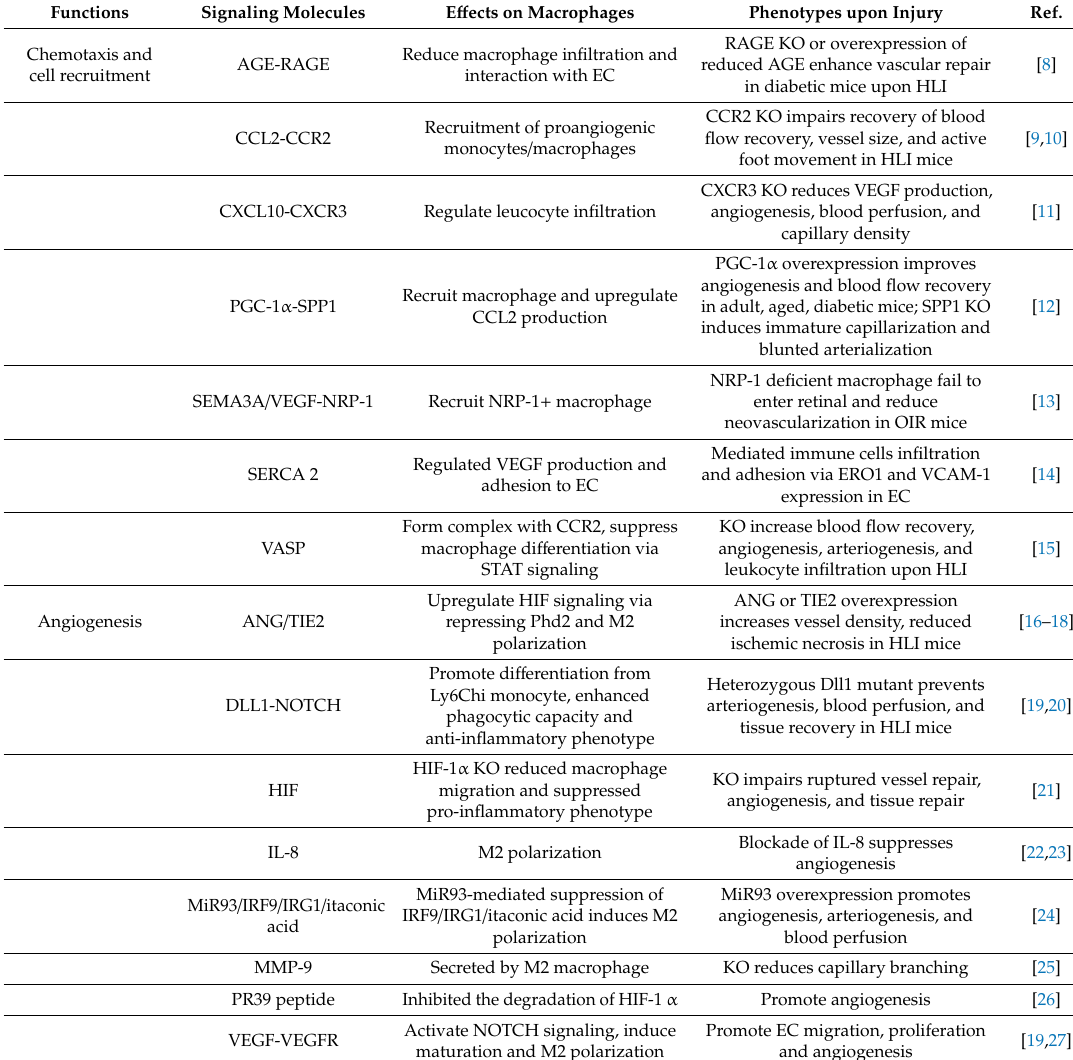
Table 1. Signaling molecules in macrophage-mediated vascular repair and